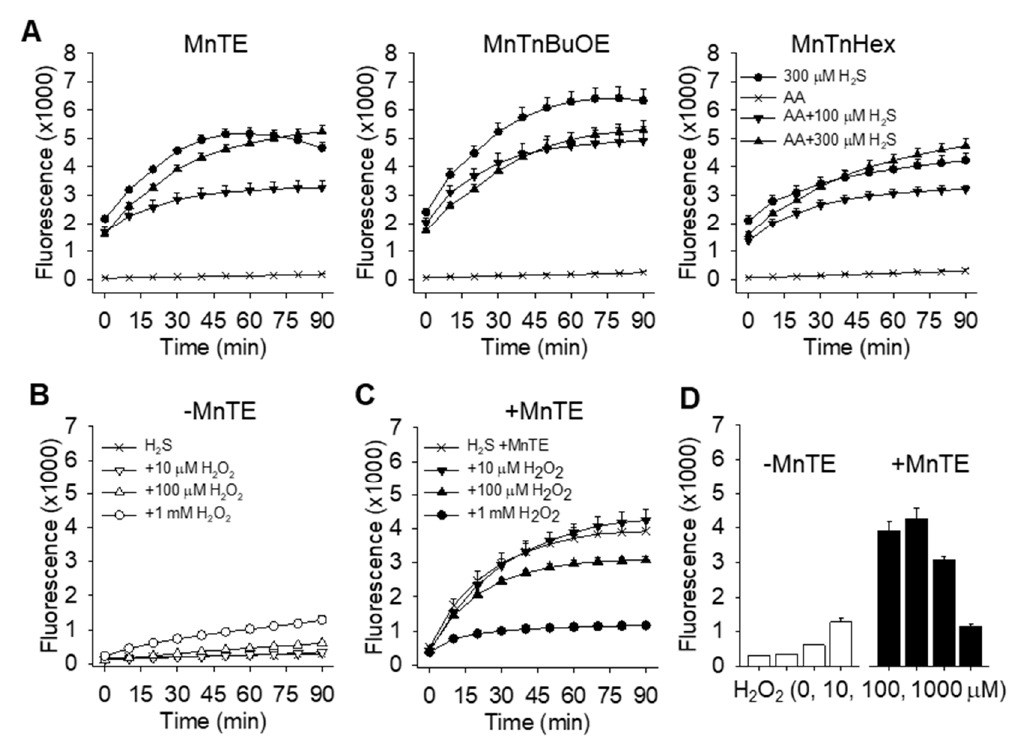
Figure 7. E ff ects of ascorbic acid (AA) and hydrogen peroxide (H 2 O 2 ) on MnP formation of polysulfides (H 2 S n ; SSP4 fluorescence) from H 2 S in 21% O 2 . ( A ) AA (1 mM) does not increase polysulfide production from 100 or 300 µ M H 2 S by 1 µ M MnPs. ( B ) H 2 O 2 alone has minimal e ff ect on polysulfide production from 300 µ M H2S in the absence of MnTE, and only decreases polysulfide production in the presence of 1 µ M MnTE ( C ). ( D ) Summary of the e ff ects of H 2 O 2 from B and C at 90 min. Mean + SE n = 4 wells per treatment.